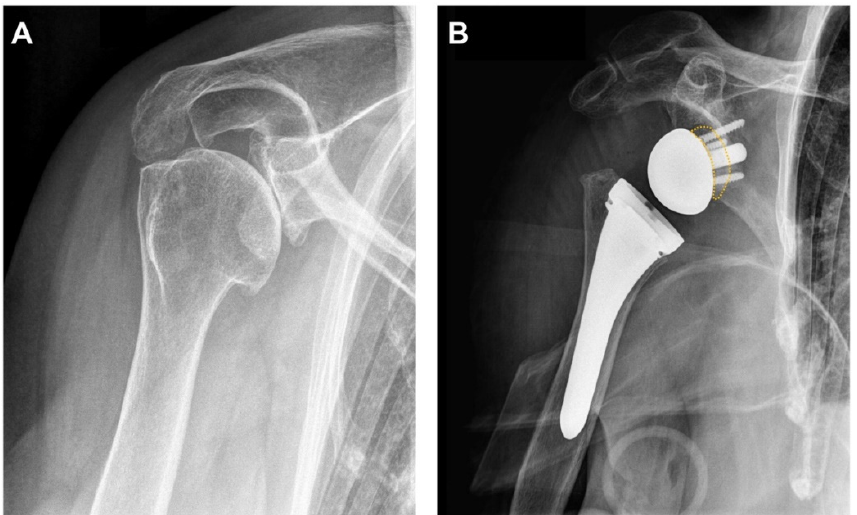
Figure 3. Standard anteroposterior radiographs of a right shoulder before and after implantation of a reverse total shoulder arthroplasty: ( A ) Cuff arthropathy of the shoulder with increased posterior glenoid wear. ( B ) Implantation of an uncemented MyShoulder (R) (Medacta, Castel San Pietro, Switzerland). Additionally, a bony lateral increased-offset harvested from the humeral head was implanted between the glenoid baseplate and the native glenoid (yellow dotted line).